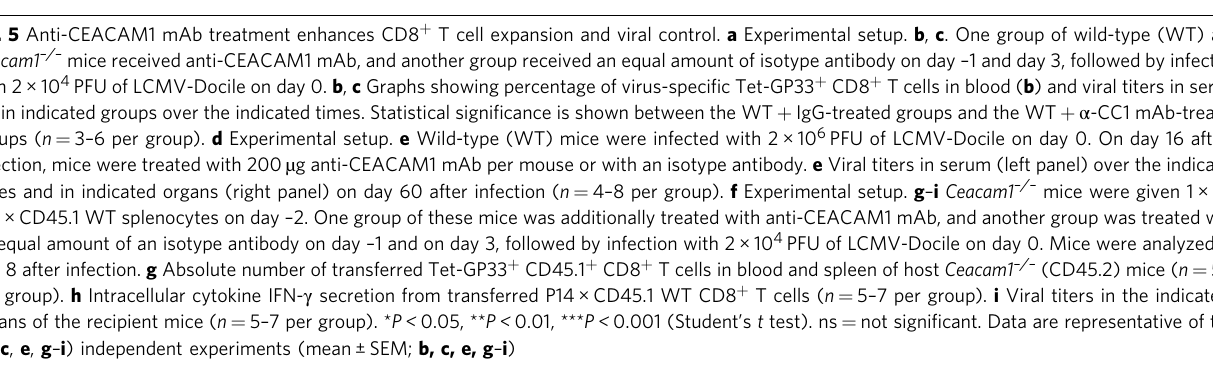
Fig. 5 Anti-CEACAM1 mAb treatment enhances CD8 + T cell expansion and viral control. a Experimental setup. b , c . One group of wild-type (WT) and Ceacam1 – / – mice received anti-CEACAM1 mAb, and another group received an equal amount of isotype antibody on day – 1 and day 3, followed by infection with 2 × 10 4 PFU of LCMV-Docile on day 0. b , c Graphs showing percentage of virus-speci fi c Tet-GP33 + CD8 + T cells in blood ( b ) and viral titers in serum ( c ) in indicated groups over the indicated times. Statistical signi fi cance is shown between the WT + IgG-treated groups and the WT + α -CC1